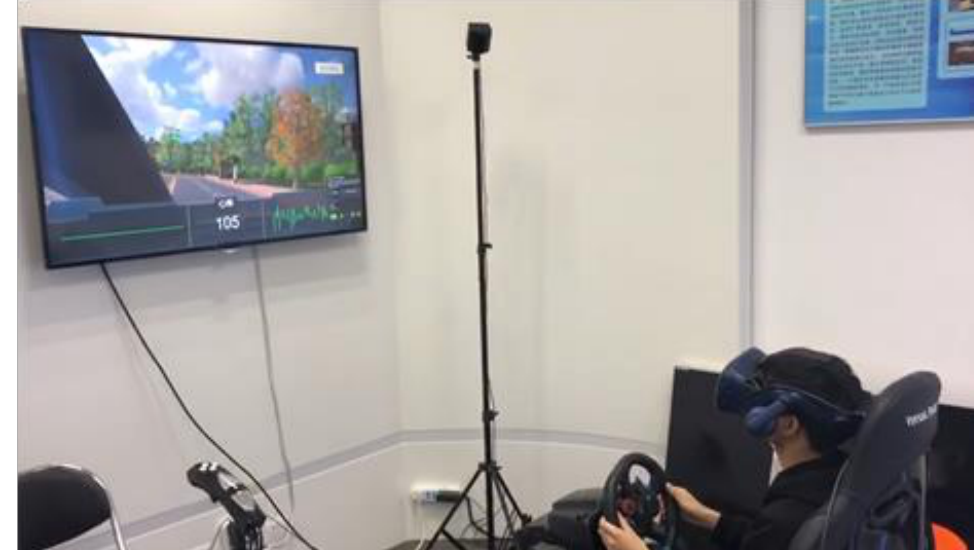
Figure 2. The VR driving system.